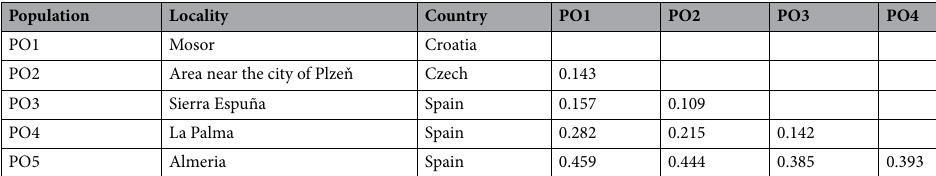
Table 2. Pairwise values of genetic differentiation (F ST ) between European aoudad populations based on 15 microsatellite loci. All pairwise F ST values between populations were significant at P <